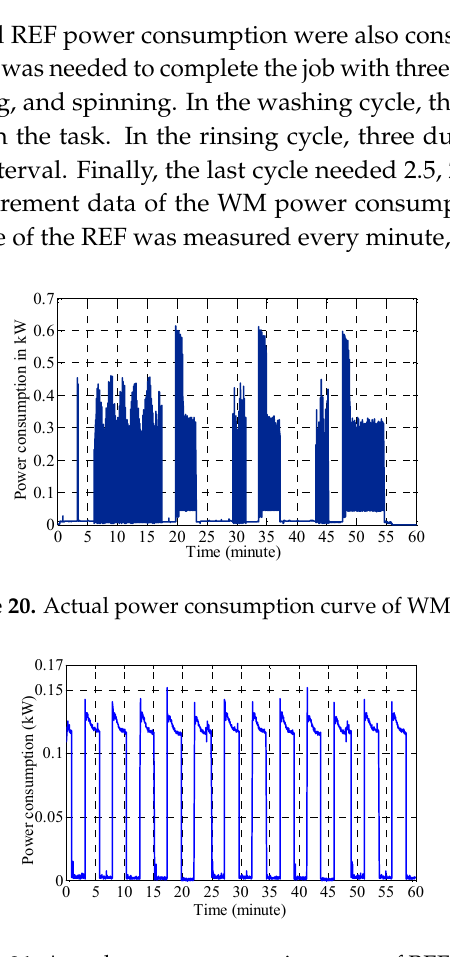
Figure 19. Measured solar irradiation data.